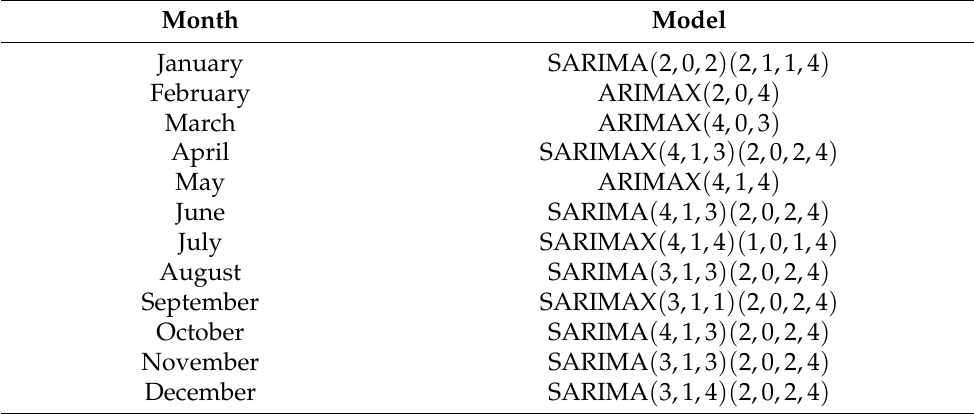
Table 5. Summary of the best ARIMA-based model for each month of the year. Table A1 reports the full results for different considered